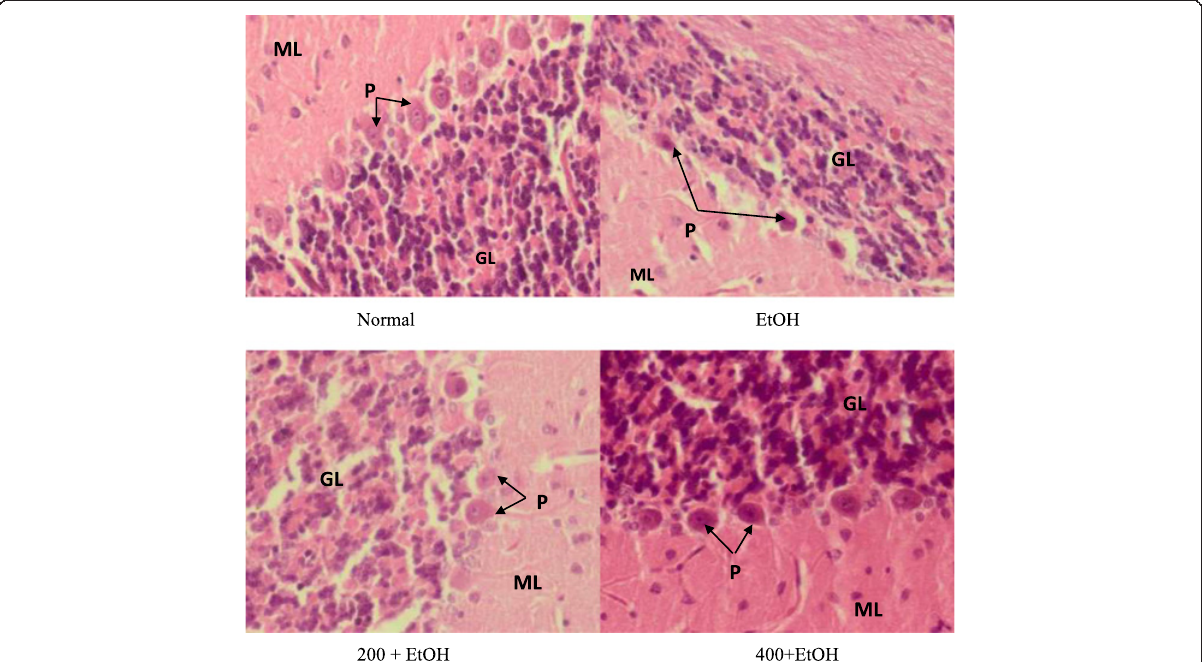
Fig. 3 Brain sections (cerebellum) from each group (magnification × 40). Note the number of Purkinje cells. (P- Purkinje cell; ML-Molecular layer; GL-Granular layer). ( N = 6). (EtOH: ethanol; 200 + EtOH: 200 mg/kg extract + ethanol; 400 + EtOH: 400 mg/kg extract +